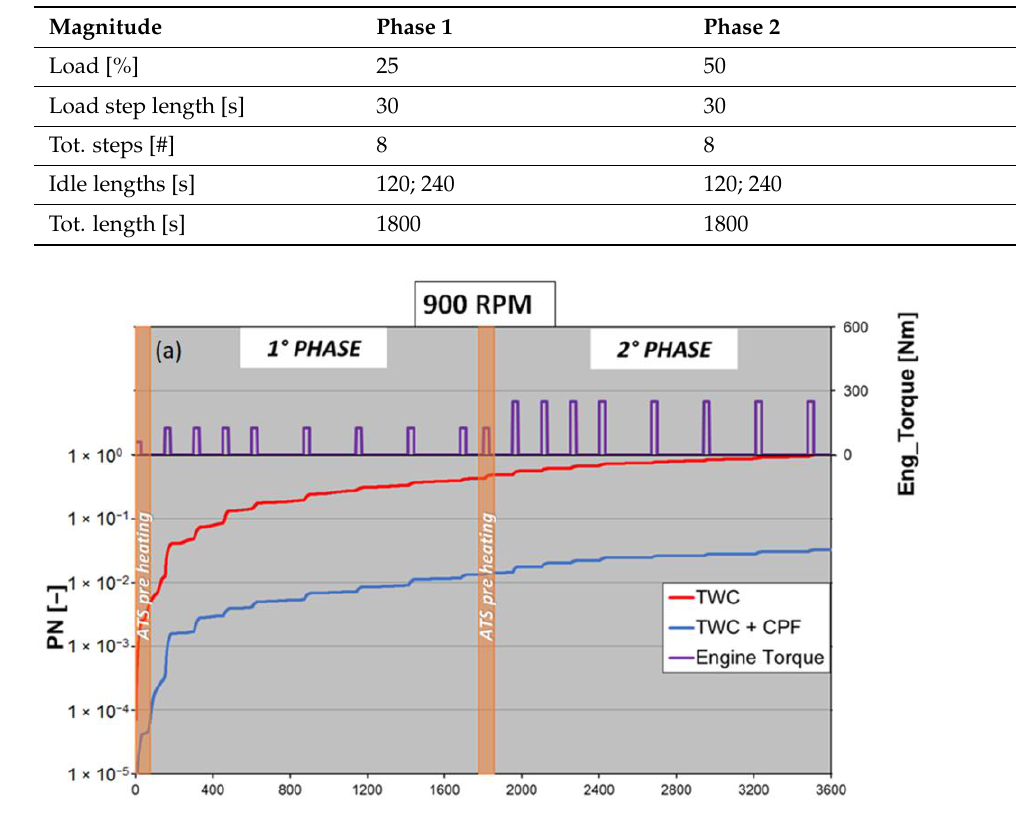
Table 10. The CPF test characteristics valid for both 900 and 1400 rpm.